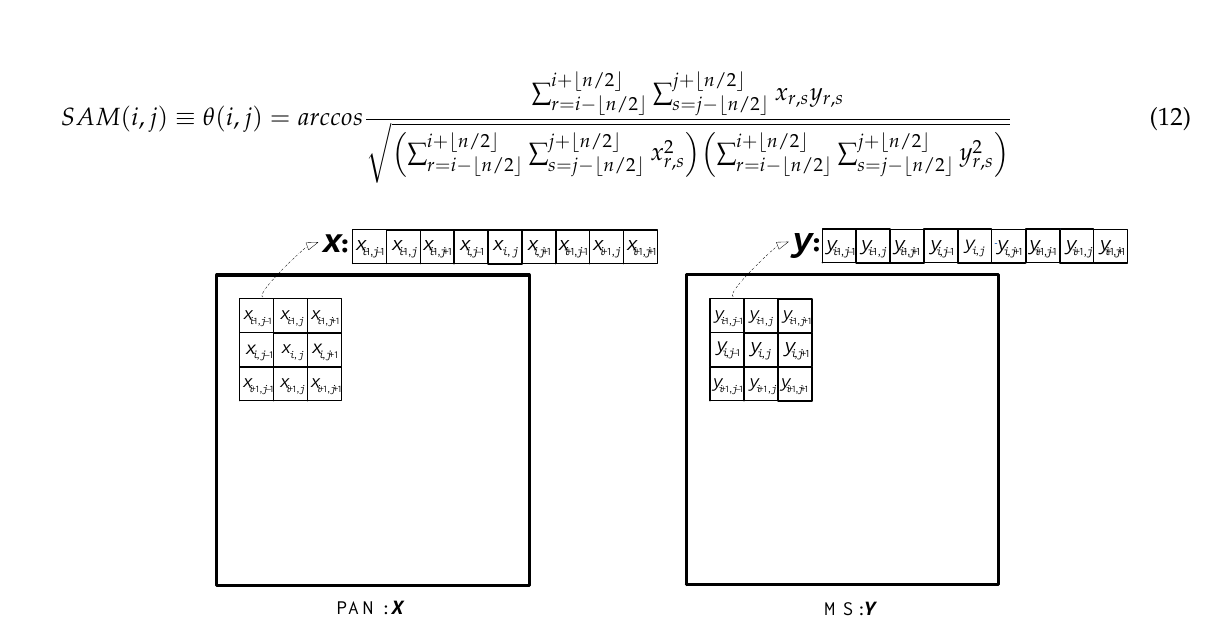
Figure 4. 3 × 3 adjacent region elements vector diagram.